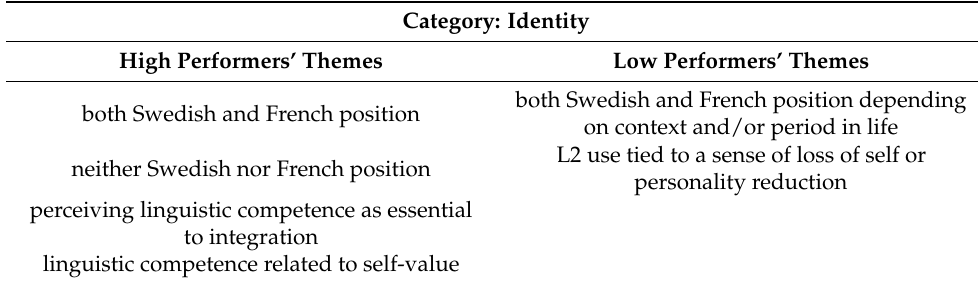
Table 5. Identified themes in the category “Identity”. Category: Identity High Performers’ Themes Low Performers’ Themes both Swedish and French position depending both Swedish and French position on context and/or period in life L2 use tied to a sense of loss of self or neither Swedish nor French position personality